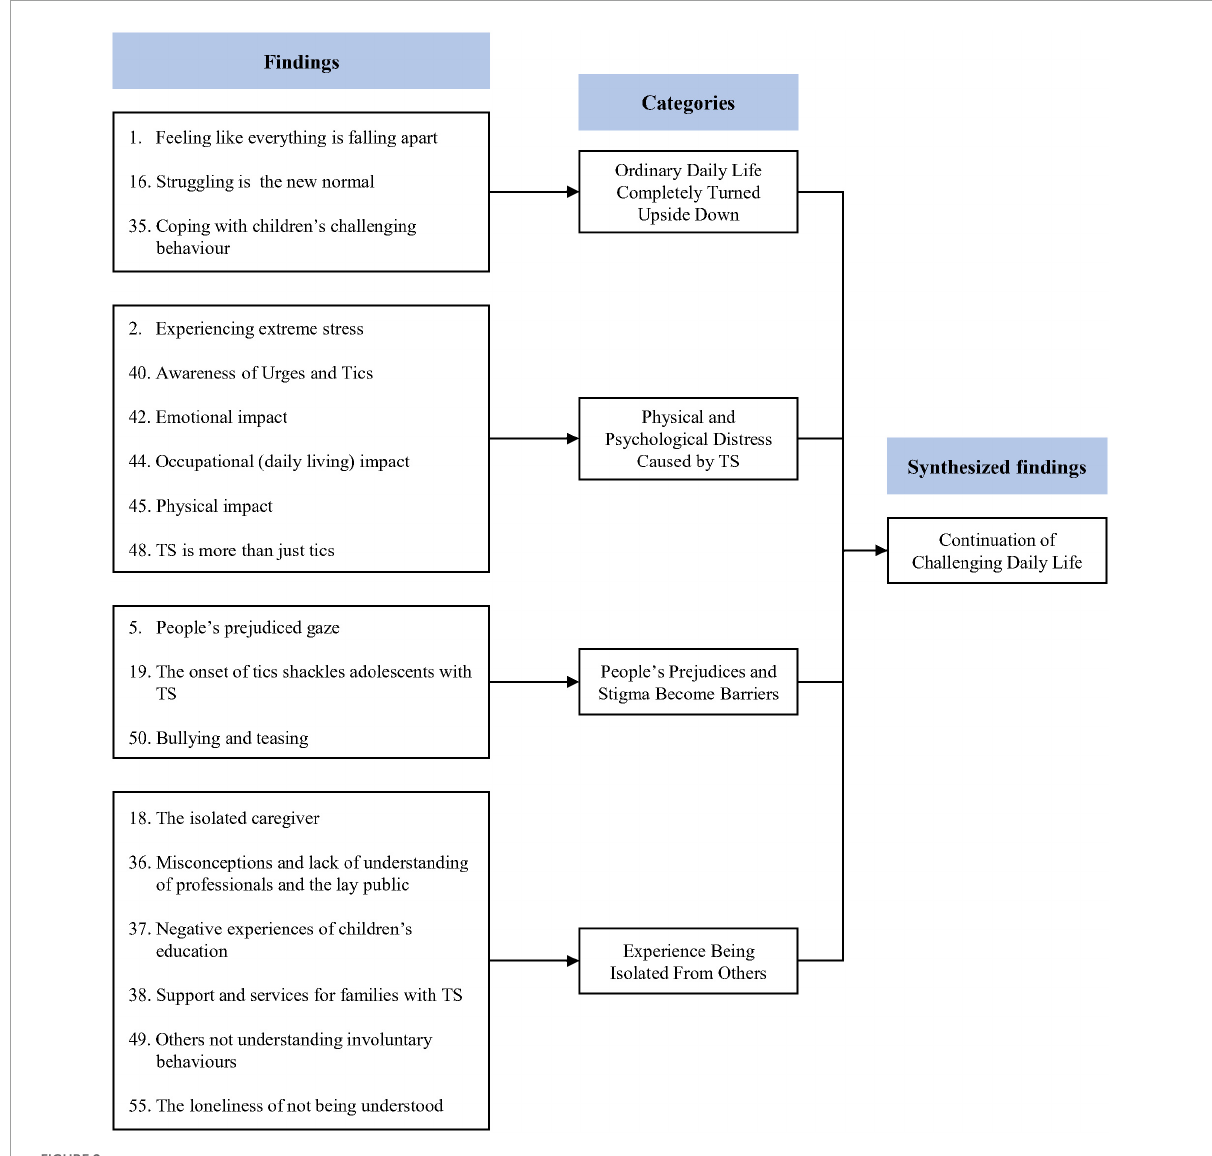
FIGURE2 Synthesized finding 1: Continuation of challenging daily